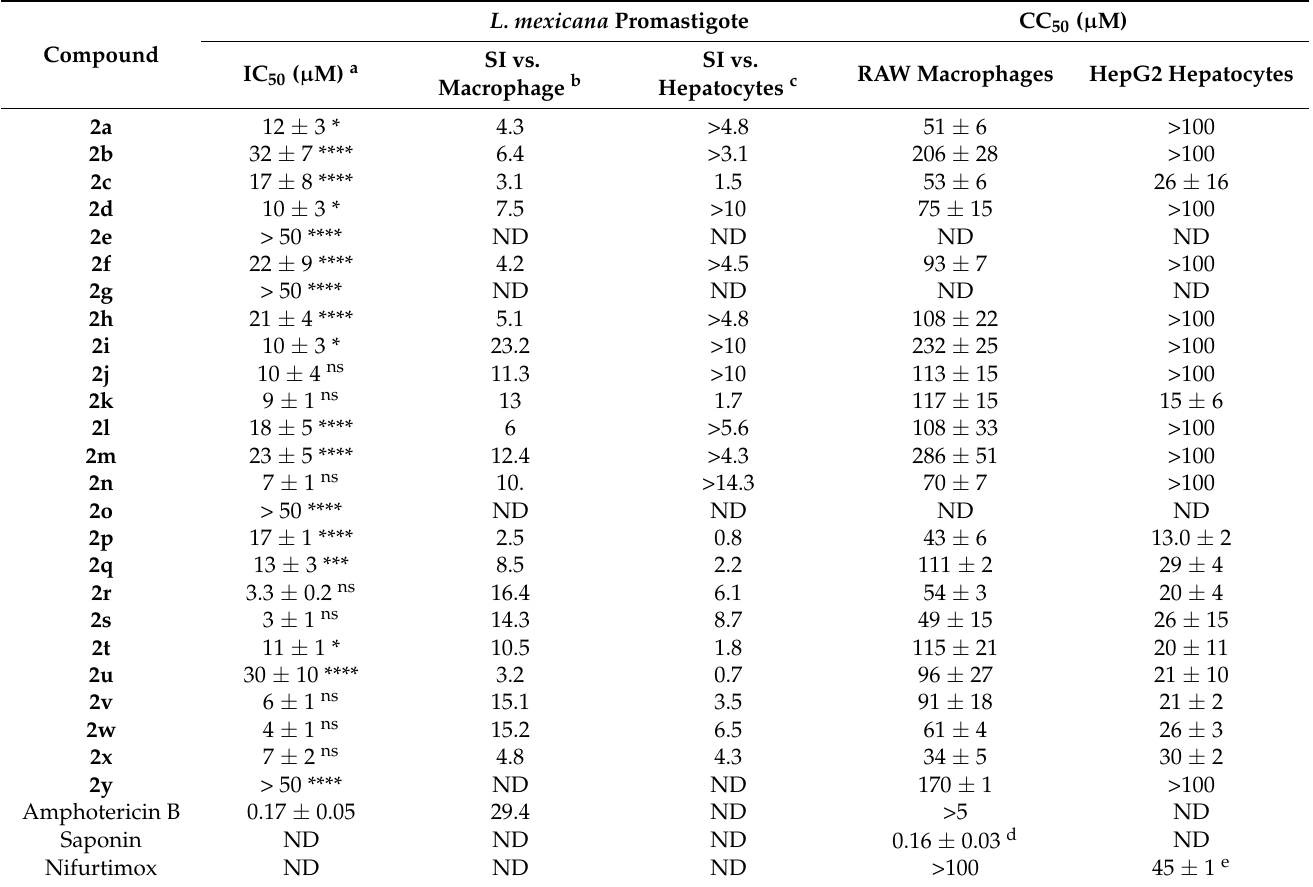
Table 2. Anti-leishmanial and cytotoxic activities of 4,4 (cid:48) -(arylmethylene)bis(3-methyl-1-phenyl-1 H - pyrazol-5-ols) 2a –